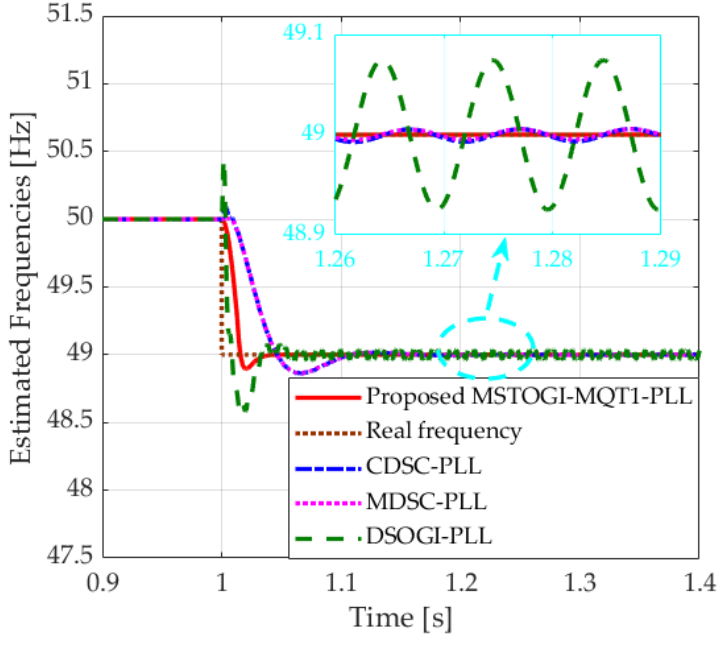
Figure 19. Estimated frequency for all studied methods for scenario 3.